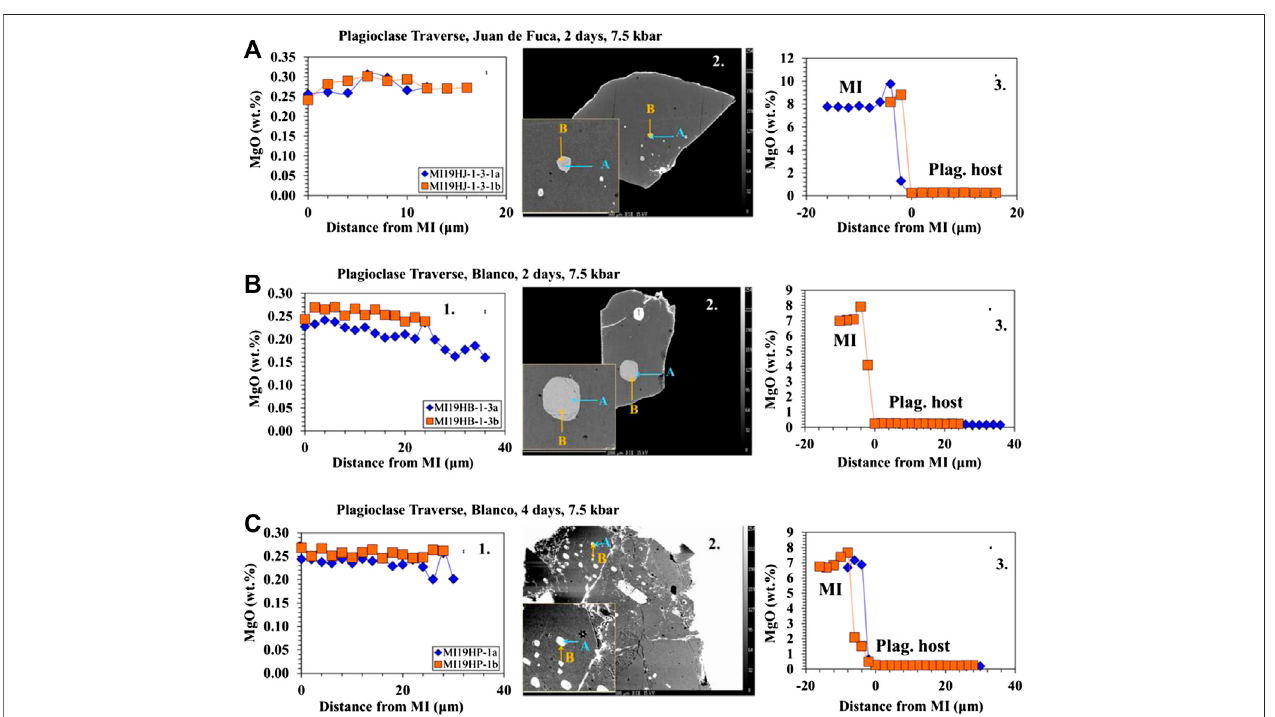
FIGURE7| Majorelementpro fi lesbetweenthehostplagioclaseandtheMIforhighpressureexperiments.1)Thepro fi lefromtheplagioclasehost(right)intotheMI (left) marked by an increase in MgO. Spike in MgO within the MI is a result of quench crystallization. Error bars are located in the upper right corner. 2) BSE images showing thedirectionand locationof traverses. 3) Pro fi le withinthe plagioclase hostasitapproachesthe boundary ofthe MI(markedby0distancefrom MI). (A) Pro fi les andBSEon2-dayhighpressureexperimentsforBlancoandJuandeFucasamples.ResultsshownochangeinMgOasthetraverseapproachestheMIboundary, butanincreaseinMgOattheinnerboundaryoftheMI. (B) Pro fi lesandBSEon4-dayhighpressureexperimentsforBlancosample.ResultsshowanochangeinMgOas the traverse approaches the MI boundary, but an increase in MgO at the inner boundary of the MI.